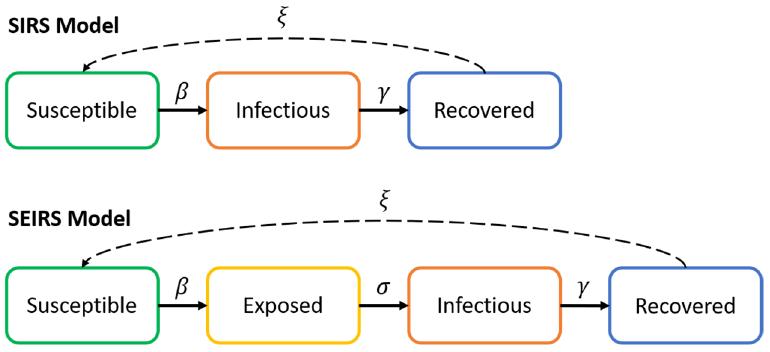
Figure 1. SIRS and SEIRS epidemiological models.